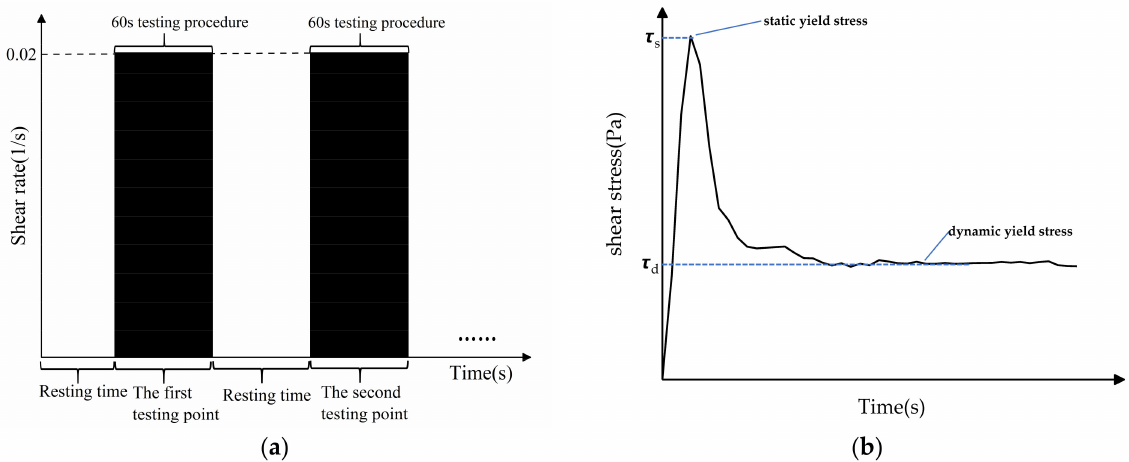
Figure 5. ( a ) The rheological test procedure for time-dependent static yield stress is conducted after the resting time (usually after the mixing time) and ( b ) the static yield stress is obtained in the